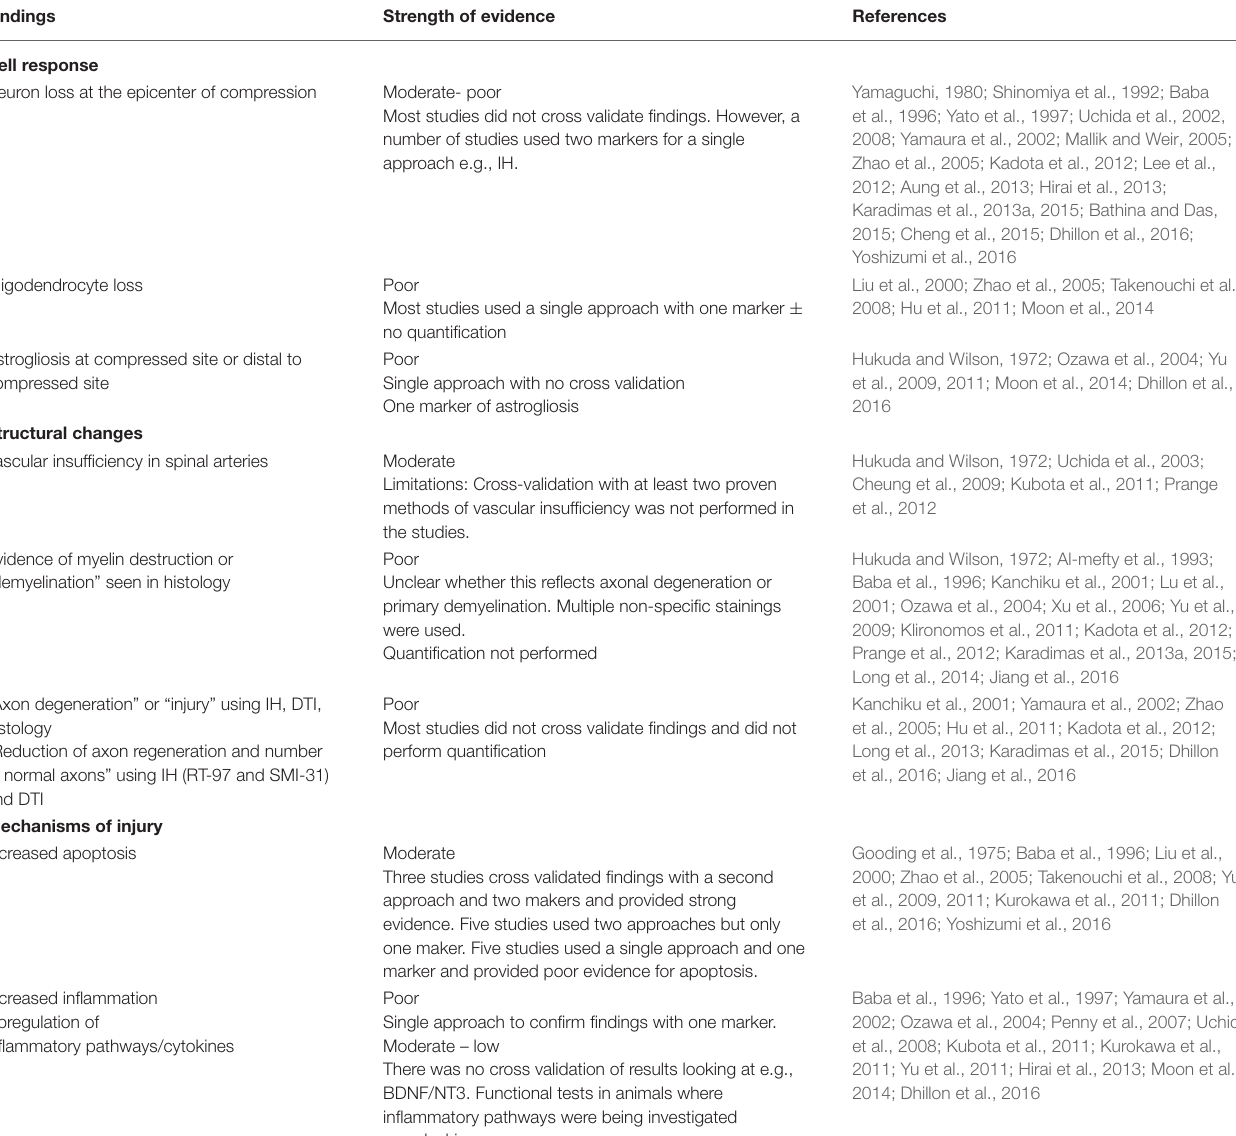
TABLE 2 | Summary of pathophysiological changes following chronic spinal cord compression.